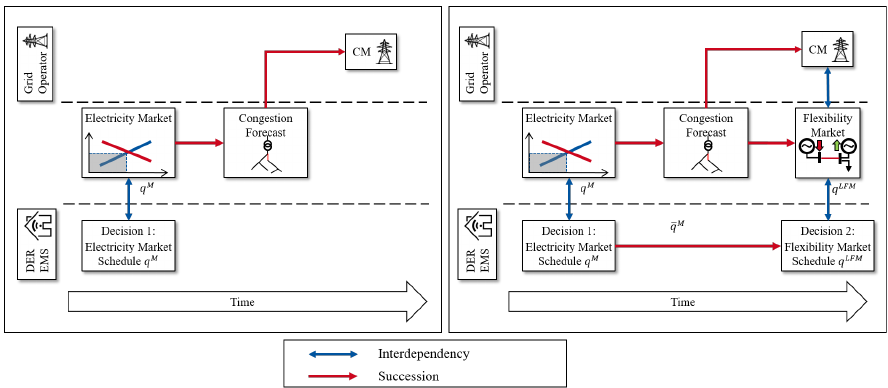
Figure 2. CM approach (left) and LFM time frame with sequential market participation